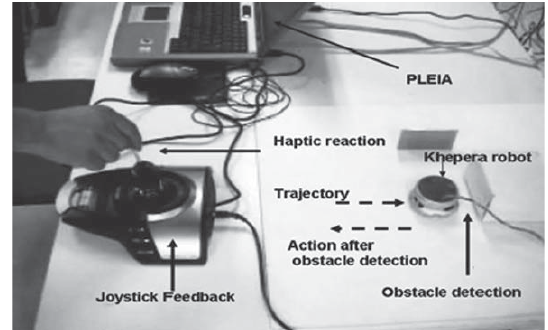
Fig. 6. Force feedback used for a haptic interface with Khepera Robot for educational and therapy sessions in PLEIA.